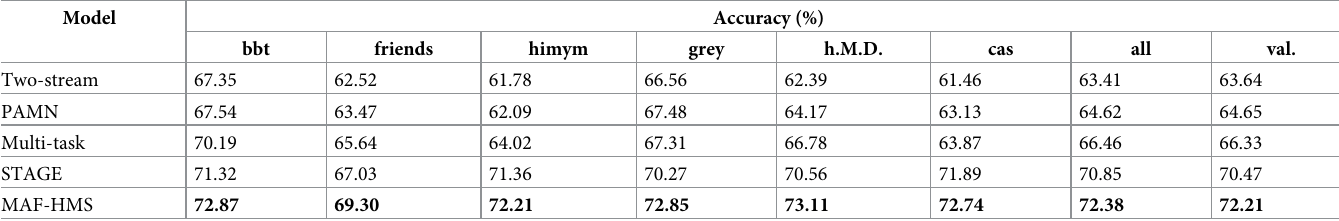
Table 1. Evaluation results on the TVQA dataset by TV show.